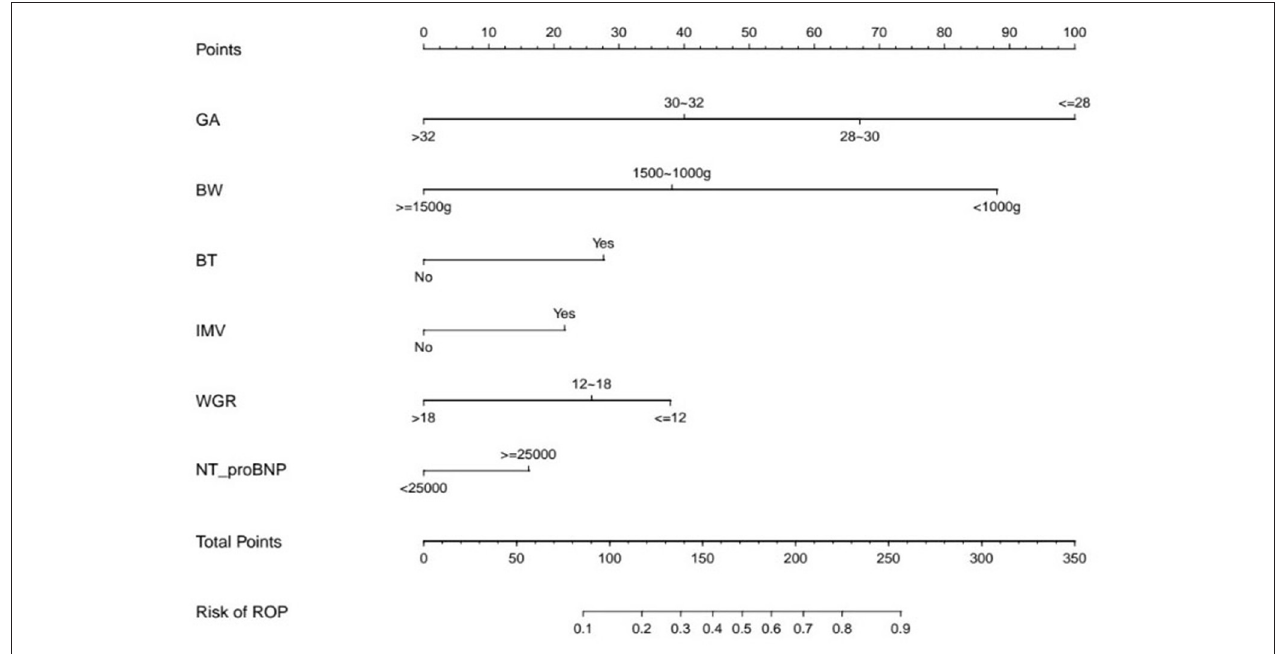
FIGURE 2 | The Nomogram Based on the Final Prediction Model. GA, gestational age; BW, birth weight; BT, blood transfusion; IMV, invasive mechanical ventilation; WGR, weight gain rate; ROP, retinopathy of